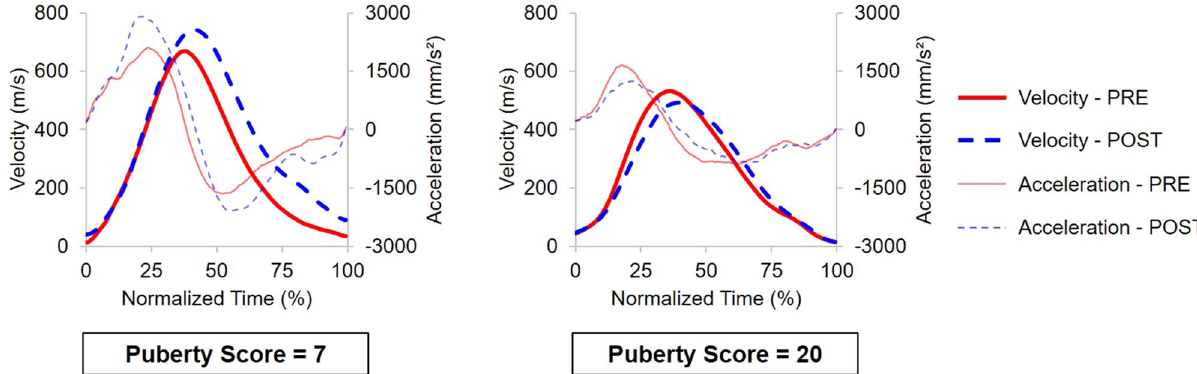
Figure 2. Average kinematic profile (18 trials) of representative early puberty (PS = 7, left panel) and late puberty participants (PS = 20, right panel). The kinematics changes after tool use are opposite as a function of the puberty score. Instead of the increased latencies and reduced amplitudes displayed by late puberty participants, early puberty ones displayed shortened latencies and larger peak